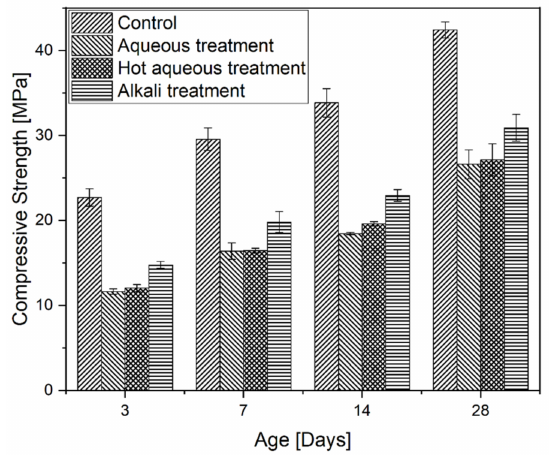
Figure 6. Compressive strength of BSC3 with different